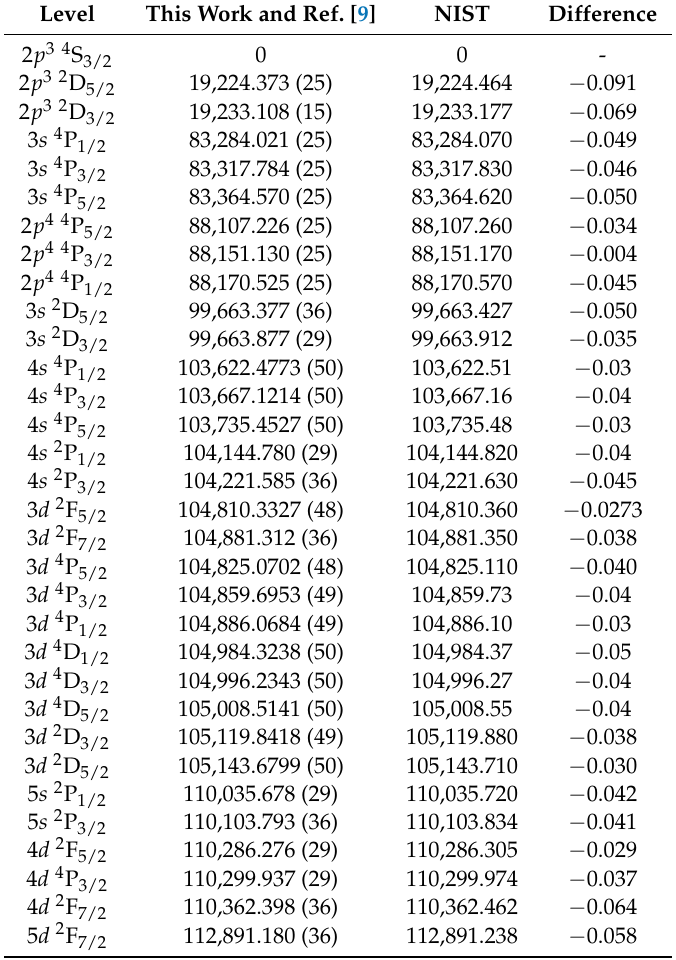
Table 5. Least-squares fitted N I level energies using the transitions from [9] and the current study. The fitted value is compared with the value of the NIST database. All values are in cm − 1 . Level This Work and Ref.